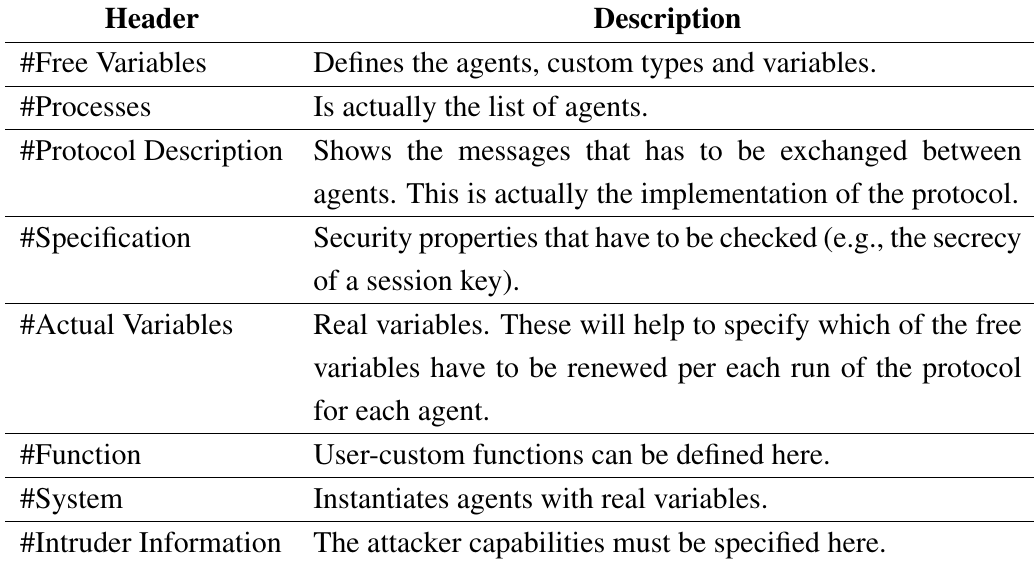
Table 6. Header description of Casper’s input file.